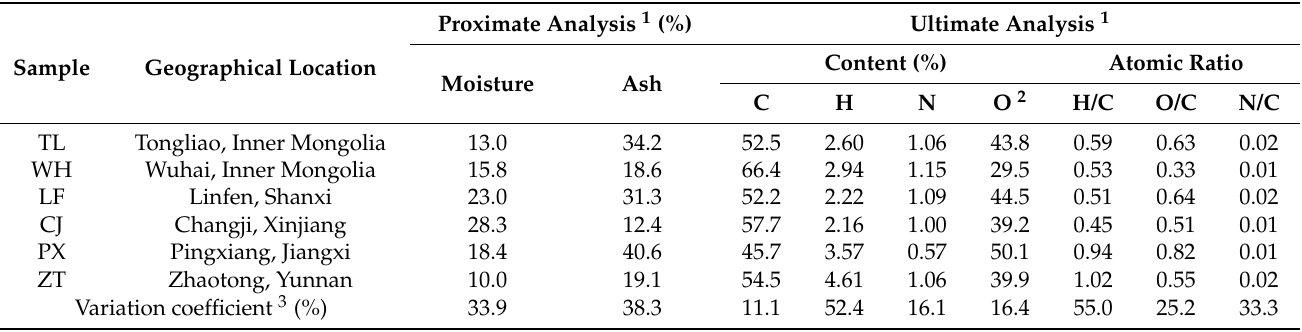
Table 1. Proximate and ultimate analysis results of weathered coal samples from different geographi- cal